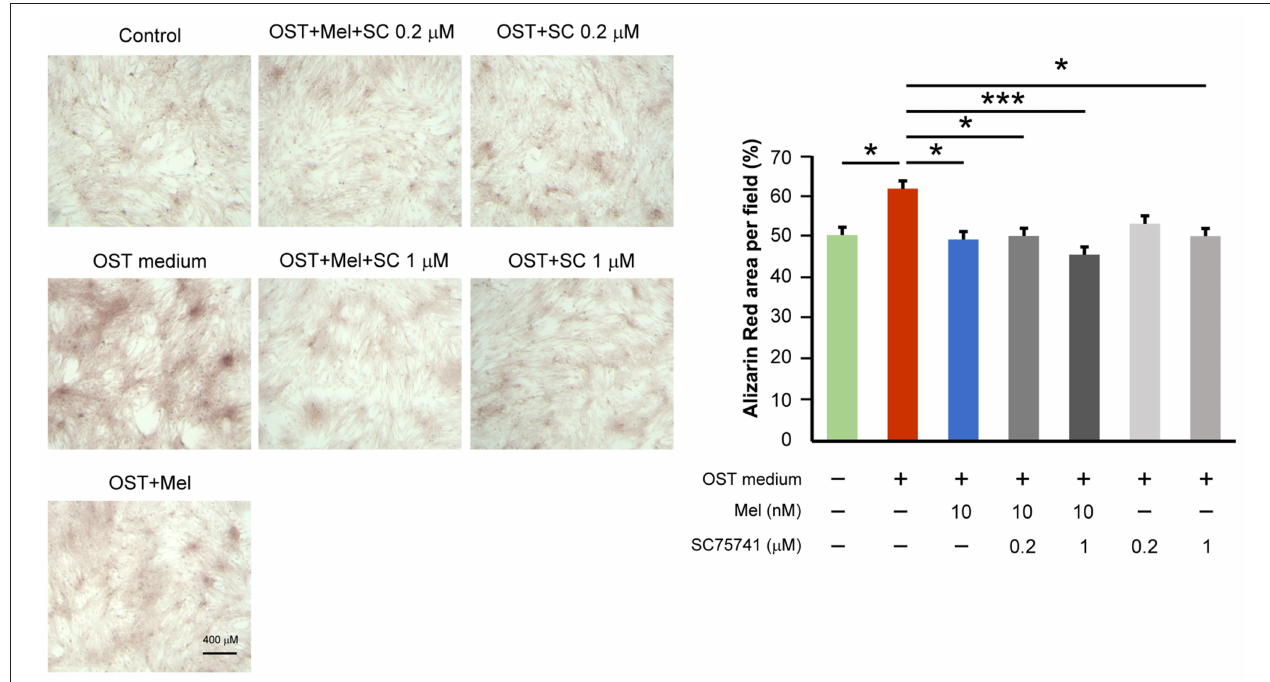
FIGURE 3 | Effect of melatonin and SC75741 on VIC calcification. The left panel depicts representative Alizarin red S staining of VICs with or without melatonin (10 nmol/L) or with or without SC75741 (0.2 and 1 µ mol/L). We quantified the positive stain area (red color) per field (three fields per treatment) in the VICs ( n = 5). The right panel presents the summary data of the percentage of calcification area ( n = 5). OST vs. OST + Mel 10nM + SC75741 1 µ M: P = 0.001. OST vs. OST + Mel 10 nM: P = 0.015. OST vs. OST + SC75741 1 µ M: P = 0.026. OST vs. OST + Mel 10nM + SC75741 0.2 µ M: P = 0.027. OST vs. negative control: P = 0.032. OST, osteogenic medium; Mel, melatonin; SC, SC75741; * P < 0.05, *** P <